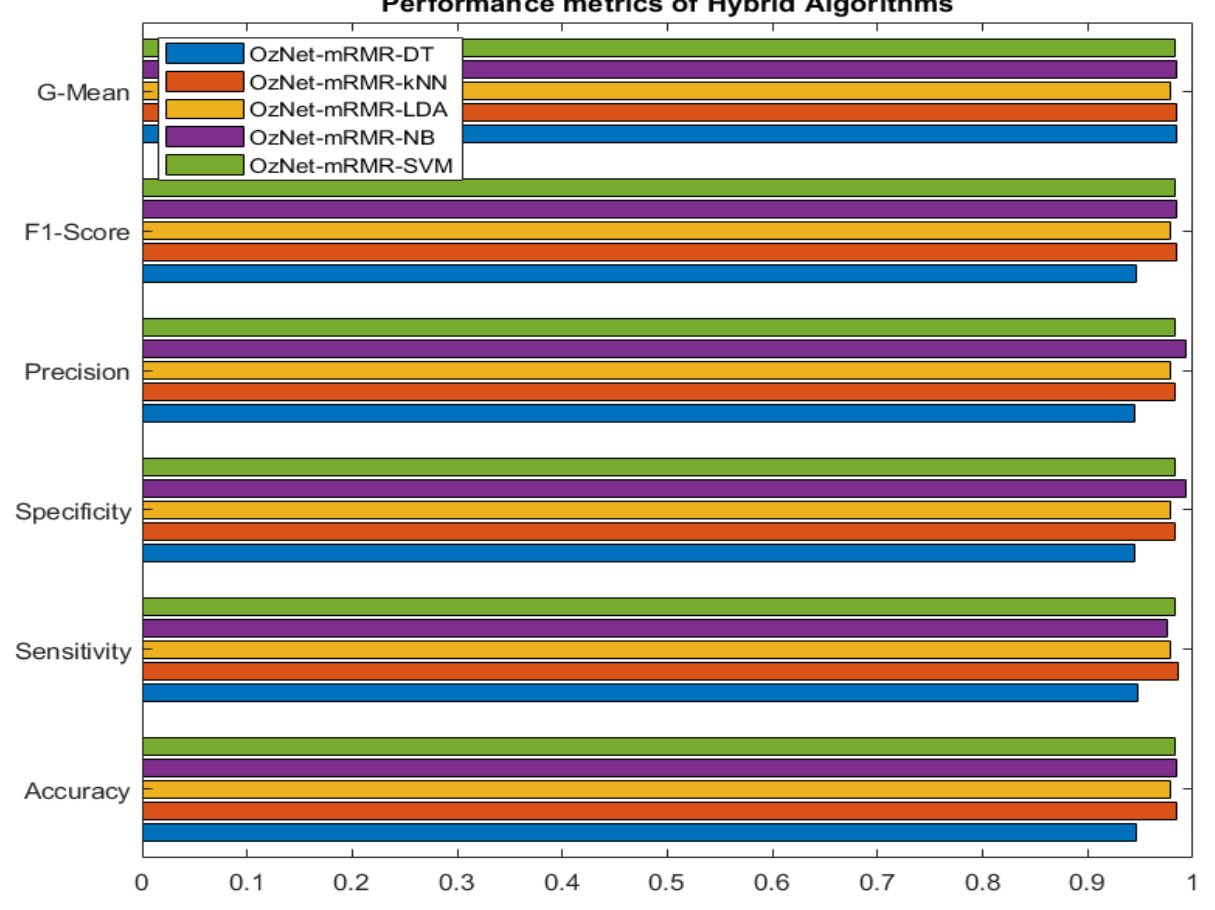
Figure 5. Performance metrics graph of different algorithms.